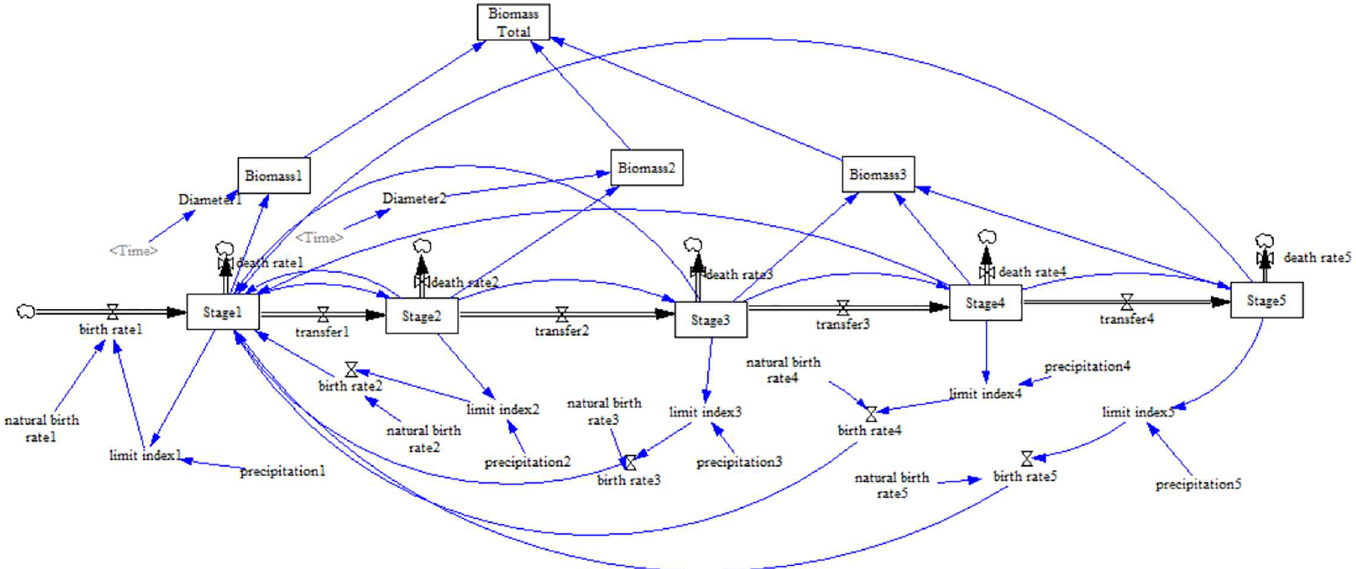
Fig 1. A stock-flow diagram representing the simulated